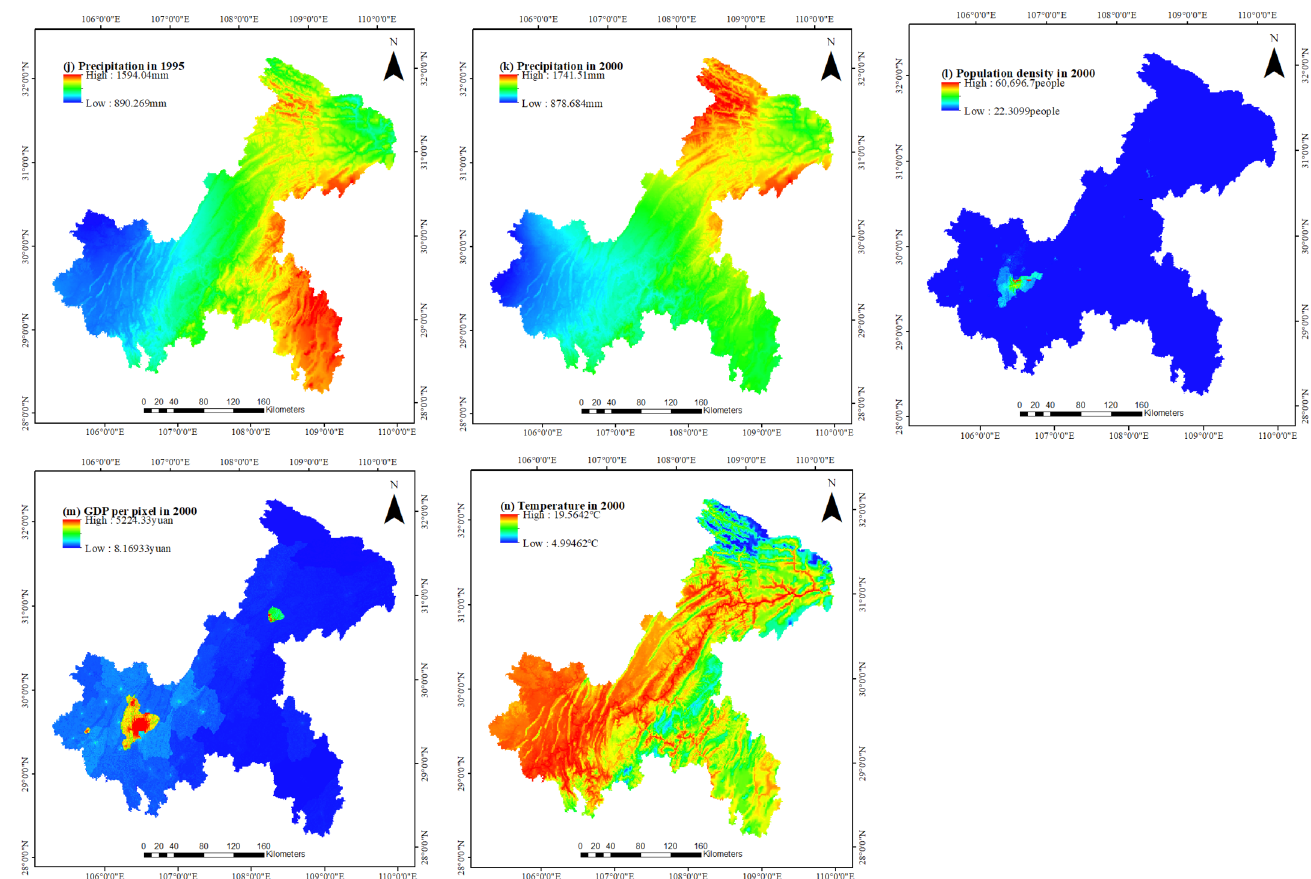
Figure 2. Maps of the various constraints: ( a ) Slope, ( b ) slope aspect, ( c ) percentage of silt, ( d ) distance from railway, ( e ) distance from road, ( f ) distance to residential area, ( g ) GDP per pixel in 1995, ( h ) temperature in 1995, ( i ) population density in 1995, ( j ) precipitation in 1995, ( k ) precipitation in 2000, ( l ) population density in 2000, ( m ) GDP per pixel in 2000, and ( n ) temperature in 2000.